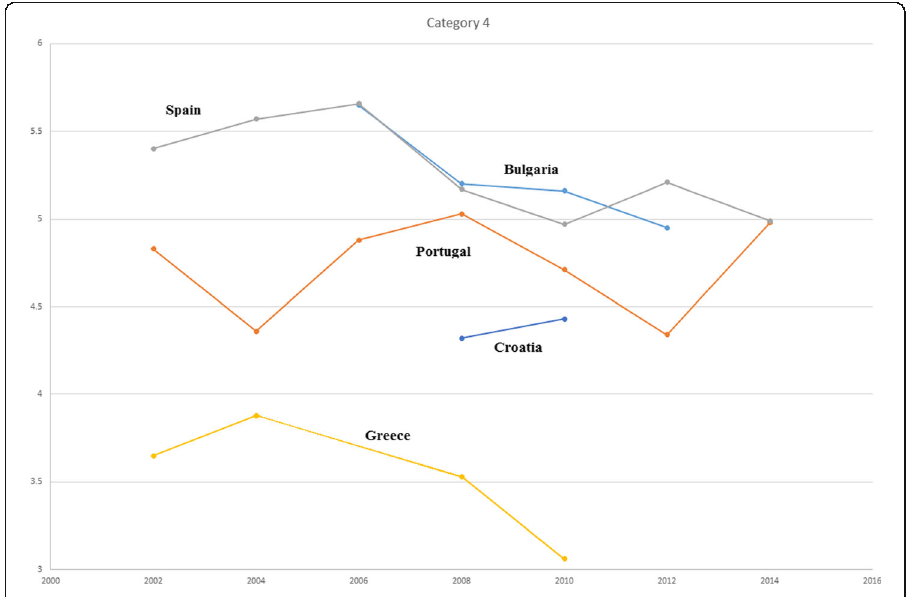
Fig. 5 Immigration good or bad for the economy (1 – 10) (Source: ESS round 1 – 7 (2002 –